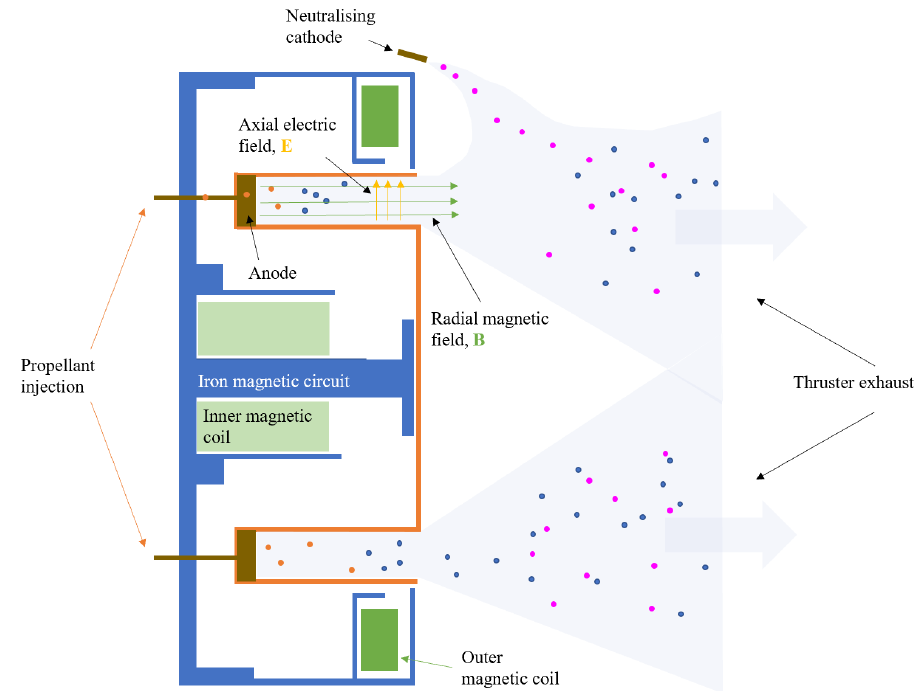
Figure 6. A simplified schematic diagram of a TAL HT or if the channel is extended this would become a SPT